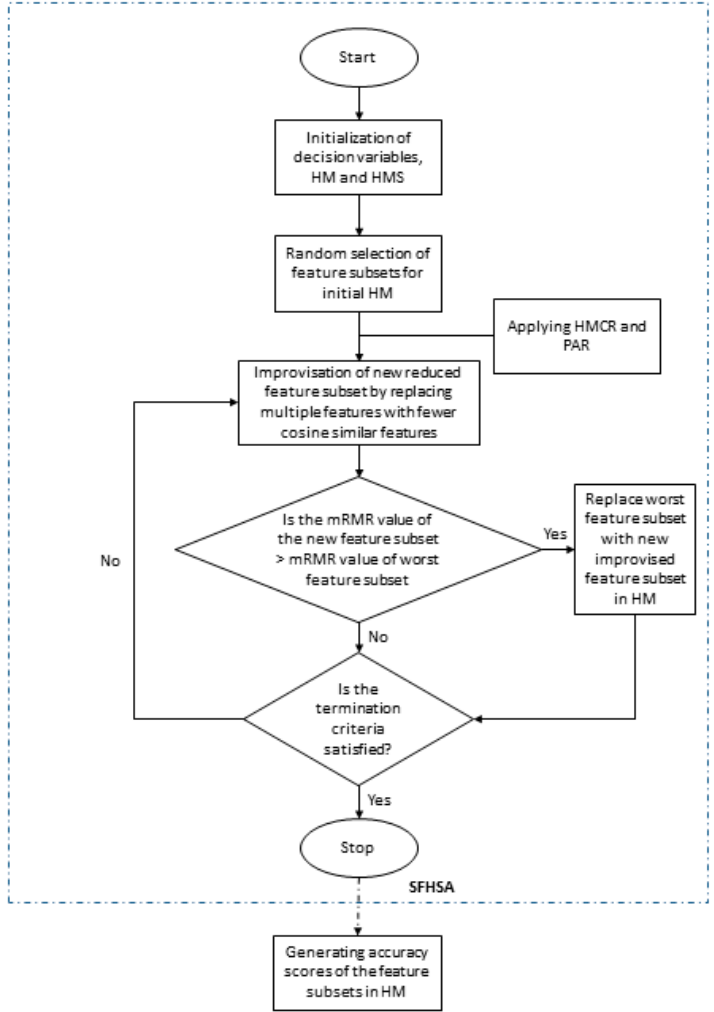
Figure 5. Diagrammatic representation of the feature selection process using supervised filter harmony search algorithm (SFHSA).